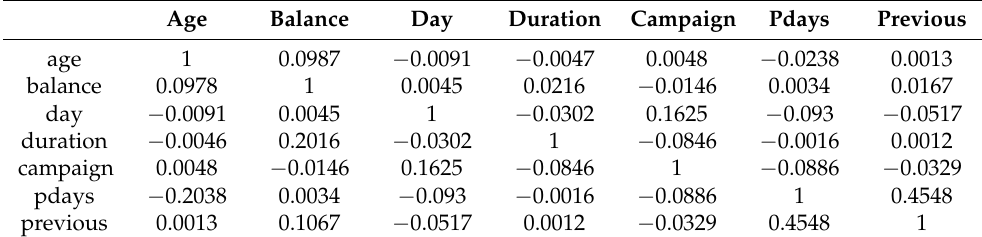
Table 3. Pearson correlation coefficient.